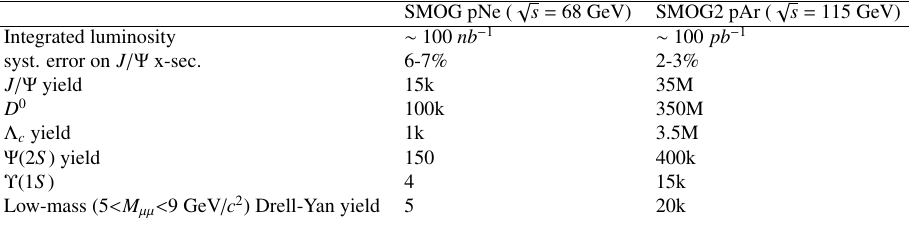
Figure 1. (a) Design of the SMOG2 storage cell; (b) side view of the storage cell connected to the VELO Table 1. Integrated luminosity and yields projection for SMOG2 in RUN3 compared with the largest SMOG sample available from